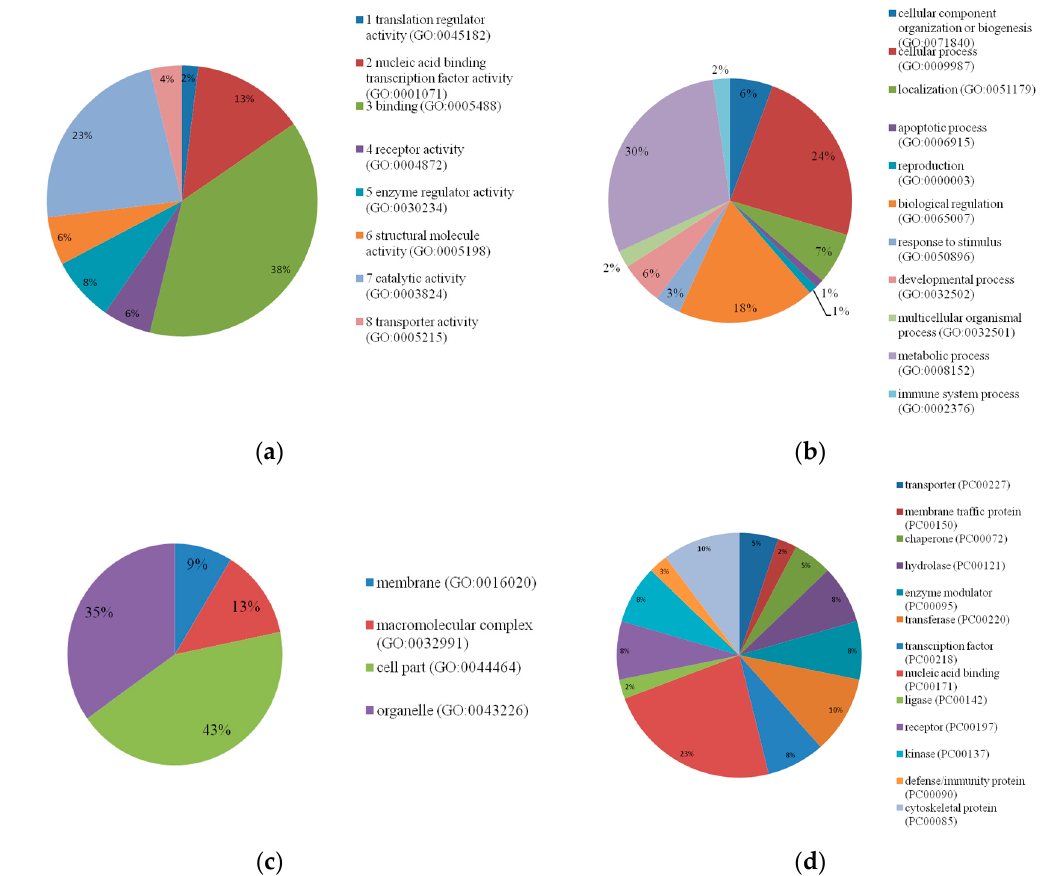
Figure 3. Functional analyses for the candidate genes found to be associated with milk fatty acids. Candidate genes were clustered based on four different potential expression profiles: molecular function ( a ), biological process ( b ), cellular component ( c ), and protein class ( d ).